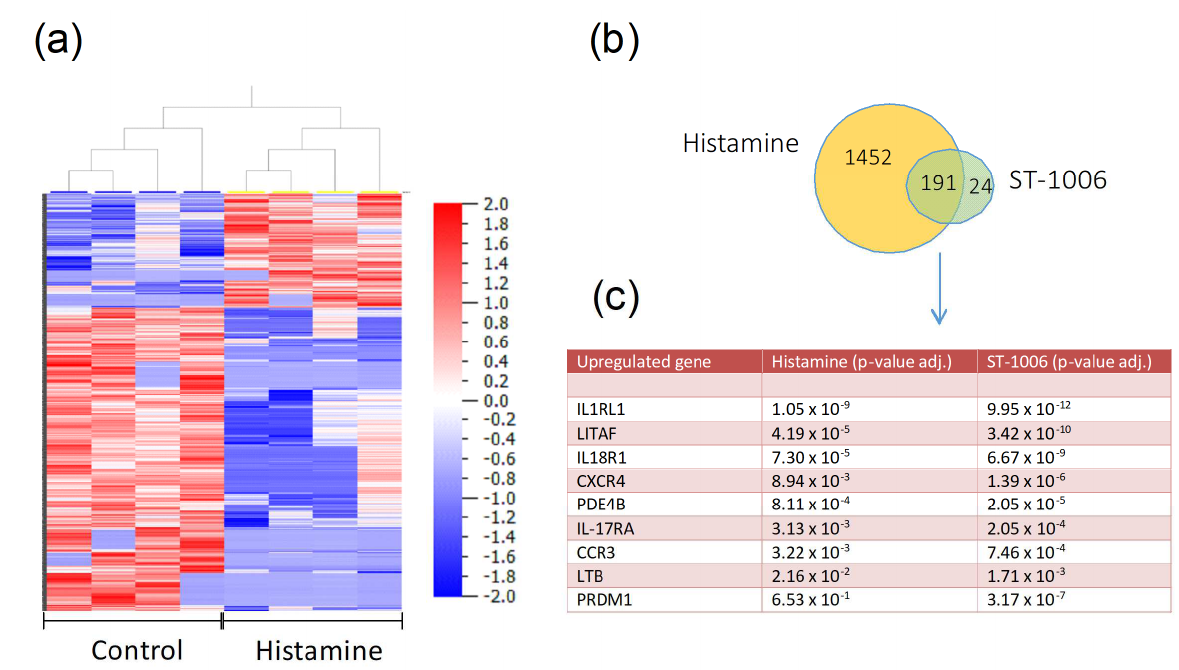
Figure 1. Histamine regulates several genes in eosinophils from AD patients. The heatmap shows the gene expression patterns of purified eosinophils from AD patients ( n = 4) without treatment (control) and after stimulation with histamine (10 μM/mL) for 6 h (histamine) ( a ). It includes all significantly regulated genes. The legend shows the visualization of the log ratio (fold change). The genes that were upregulated are shown in red. Conversely, the blue areas indicate down-regulated genes. In total, 191 genes were significantly regulated by stimulation with both histamine and the selective H 4 R agonist ST-1006 ( b ). A selection of upregulated genes associated with AD is shown in a table ( c ). The surface expression of IL-18R α was investigated by flow cytometry (Figure